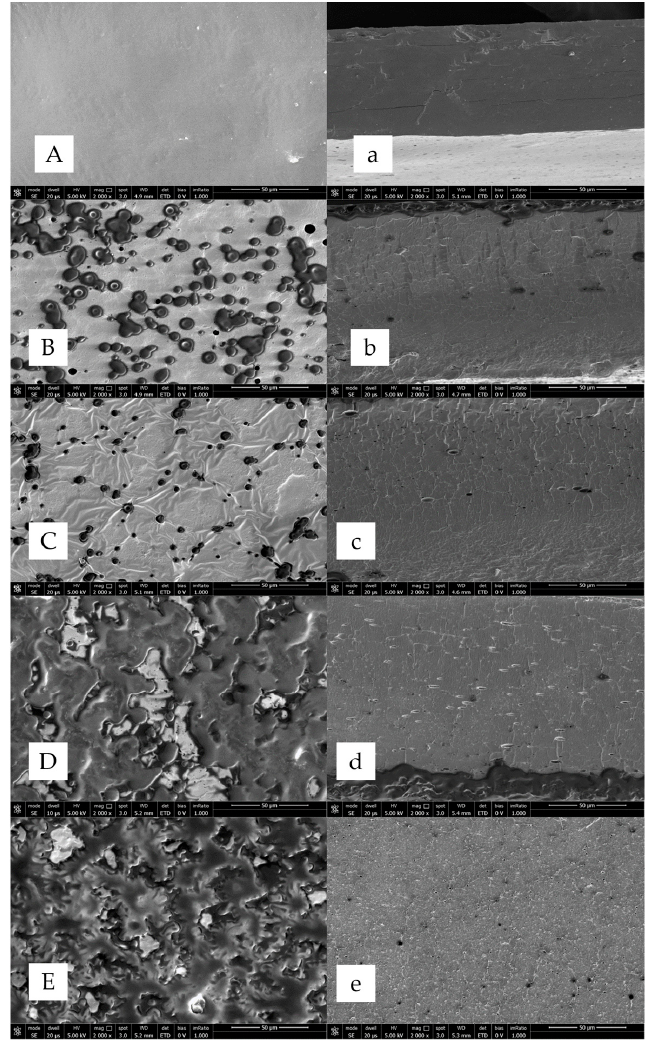
Figure 4. SEM micrographs (surface in uppercase and cross-section in lowercase) of AM100-based films ( A , a ), blended films (APs50-AM50) in the absence ( B , b ) and the presence of mTGase ( C , c ), APs100-based films in the absence ( D , d ) and the presence of mTGase ( E , e ). SEM analyses were performed at a magnification of 2000×. Further experimental details are given in the text.